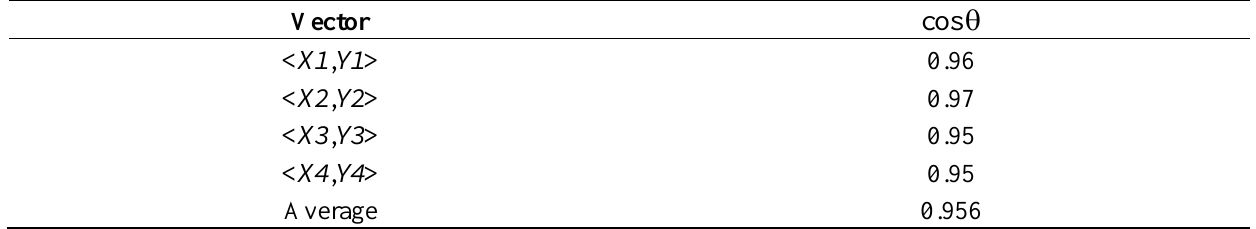
Table 8. Comparison of cosine function values between the two devices.